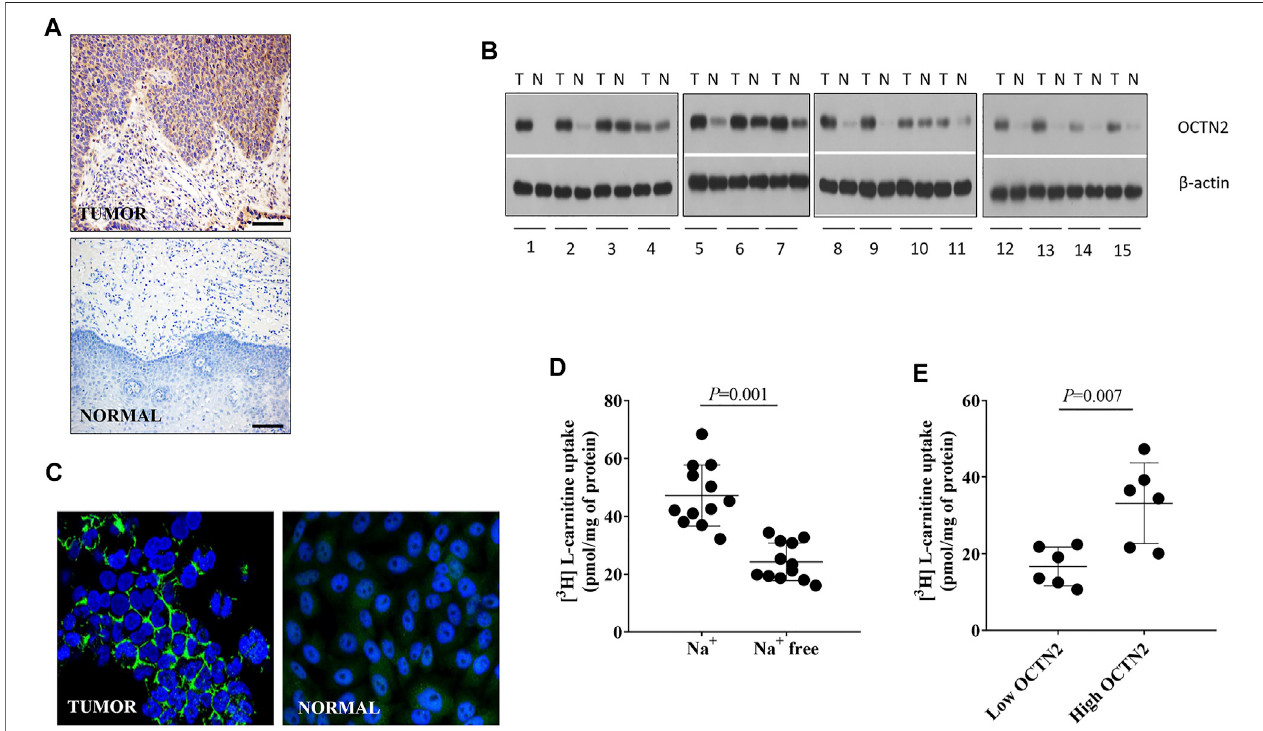
FIGURE 1 | Expression and function of OCTN2 in tumor tissues and in the respective primary cancer cells. Representative immunostaining of tumor tissue and pairednormalmucosa.Scalebar (cid:1) 100 µm (A) .Westernblotimageoftotallysates(20 µg)from15tumorsamplesandtherespectivesurroundingnormaltissuesprobed with anti-OCTN2 and anti- β -actin antibodies (B) . Representative immunostaining of OCTN2 in primary patient-derived cancer cells and paired normal mucosa. OCTN2 stainingisshowningreen; nucleiarestainedwith4,6-diamidino2-phenylindole (DAPI)inblue. Originalmagni fi cation, 200 × (C) .Five-minuteuptakeofL-carnitinein primarypatient-derivedcancercellsinthepresenceorabsenceofNa + (D) .Na + -dependentuptakeofL-carnitineinOCTN2high-expressingandlow-expressingpatient- derivedcancercells,accordingtotheOCTN2stainingscorewesternblotquanti fi cation (E) .Eachdatapointrepresentstheuptakevaluesincellsisolatedfromonetumor tissue and shown as the mean ± S.D. from three independent experiments. Statistical comparison was performed by unpaired Student ’ s